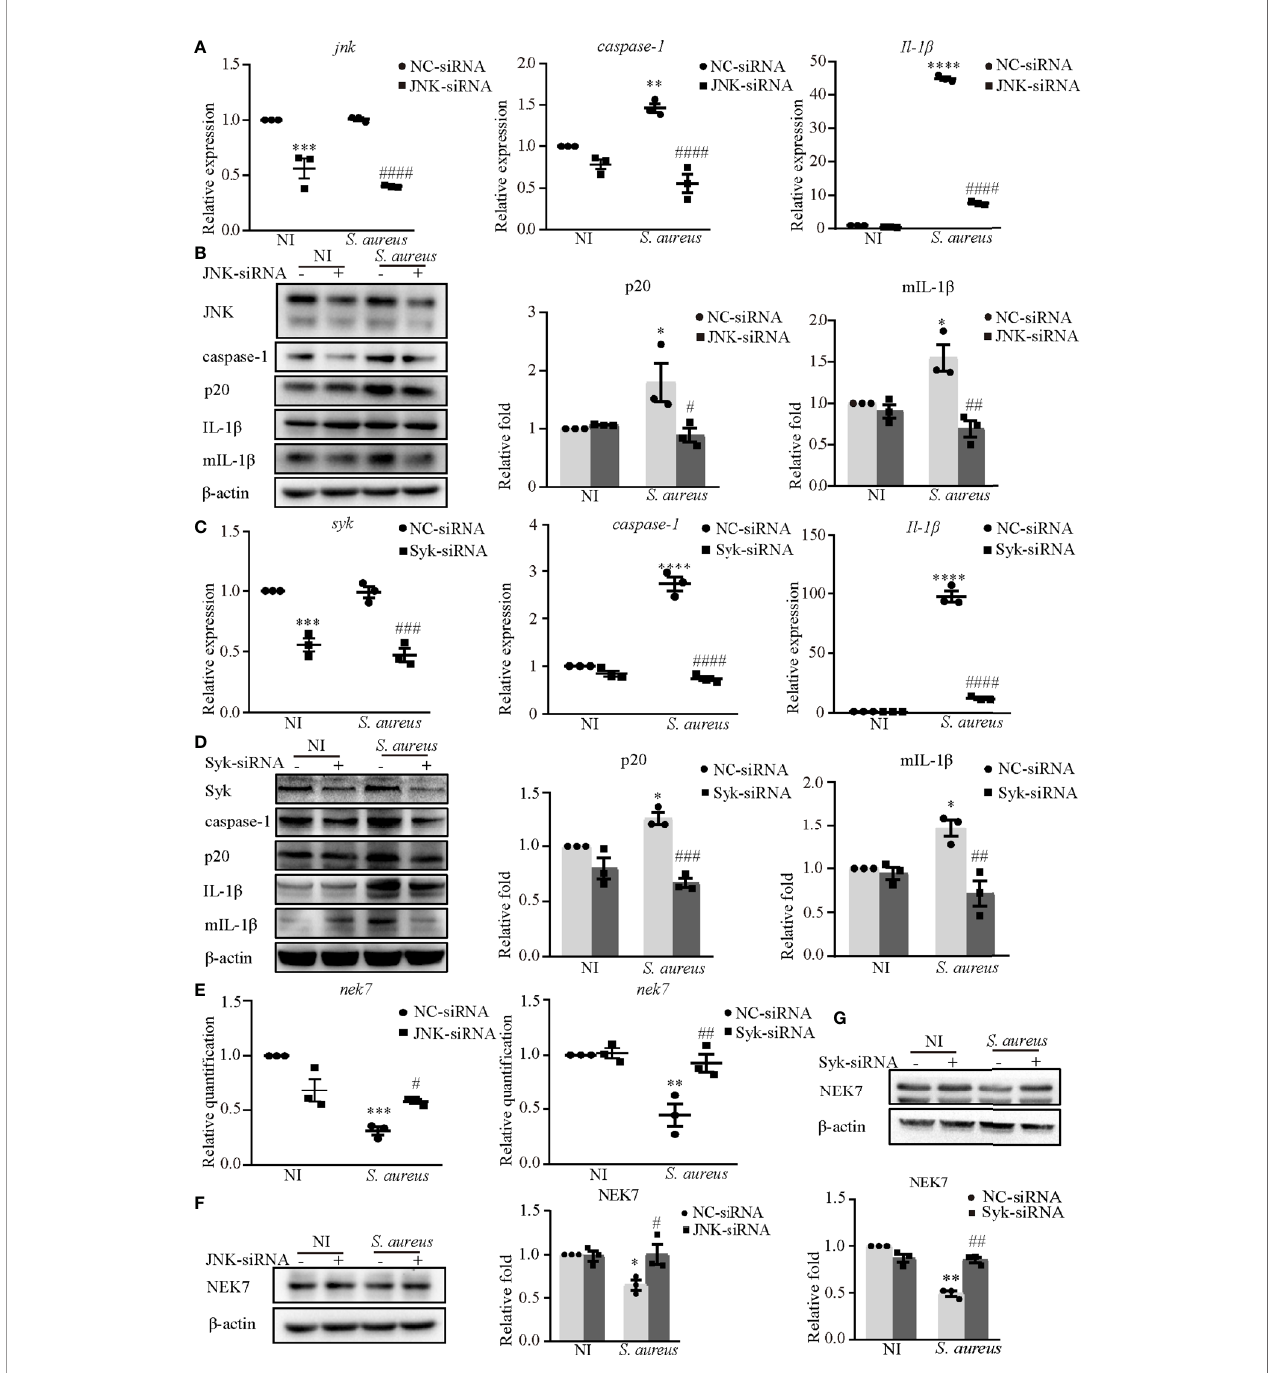
FIGURE 4 | Syk and JNK promoted the NLRP3 in fl ammasome activation upon S. aureus infection. J774A.1 cells were infected with S. aureus (MOI of 1) for 24 h with or without JNK or Syk-siRNA pretreatment for 48 h. (A) The mRNA expression levels of caspase-1 , Il-1 b in the cells pretreated with or without JNK-siRNA were quanti fi ed by RT-PCR. (B) The protein expression levels of caspase-1, p20, pro-IL-1 b and mIL-1 b were detected by western blot and analyzed using densitometry. (C) The mRNA levels of caspase-1 and Il-1 b in the cells pretreated with or without Syk-siRNA were quanti fi ed by RT-PCR. (D) The protein expression levels of caspase-1, p20, pro-IL-1 b and mIL-1 b were detected by western blot and analyzed using densitometry. (E) The mRNA expression level of nek7 was examined by RT-PCR with or without JNK/Syk-siRNA transfected. (F, G) The protein expression level of NEK7 was detected by western blot and analyzed using densitometry by transfected with or without JNK-siRNA (F) or Syk-siRNA (G) . Similar results were obtained in three independent experiments in data. Data shown are means ± SEMs; * P < 0.05, ** P < 0.01, *** P < 0.001, **** P < 0.0001 vs. non-infection control group, # P < 0.05, ## P < 0.01, ### P < 0.001, #### P < 0.0001 vs . infection control